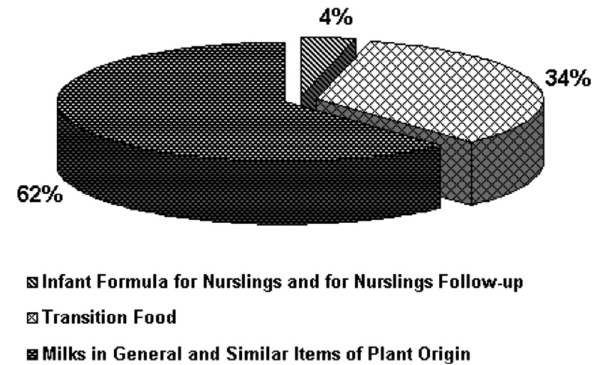
FIGURE 2 – Types of commercial promotion.